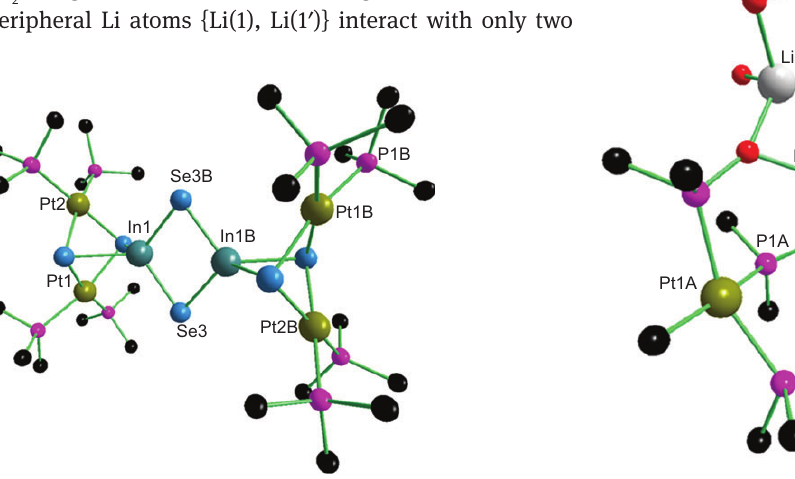
-PPh PO) Li (H O) 3 2 3 2 2